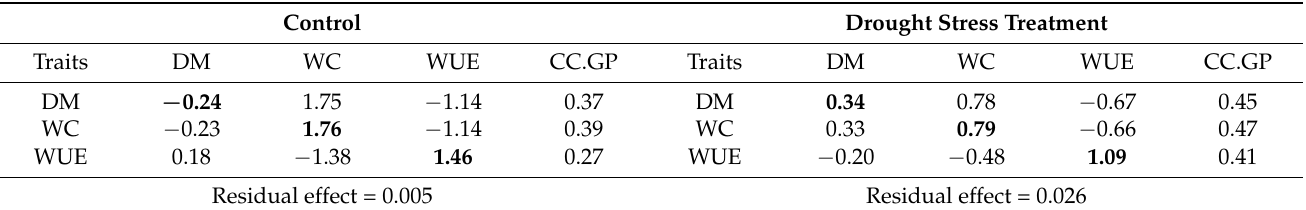
Table 4. Path analysis for the direct and indirect effects of studied traits including days to maturity (DM), water consumption (WC) and water use efficiency (WUE) on the grain productivity (GP) of lowland rice cultivars under control and drought stress treatments.